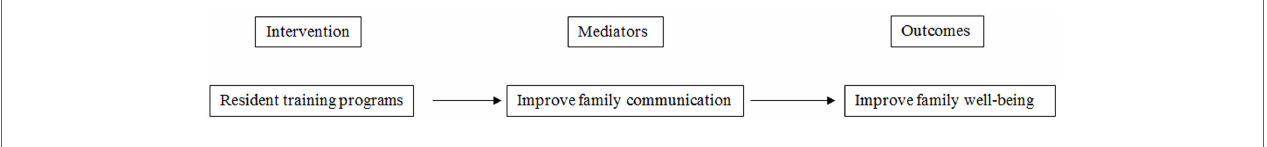
FigUre 1 | Pathway of intervention on